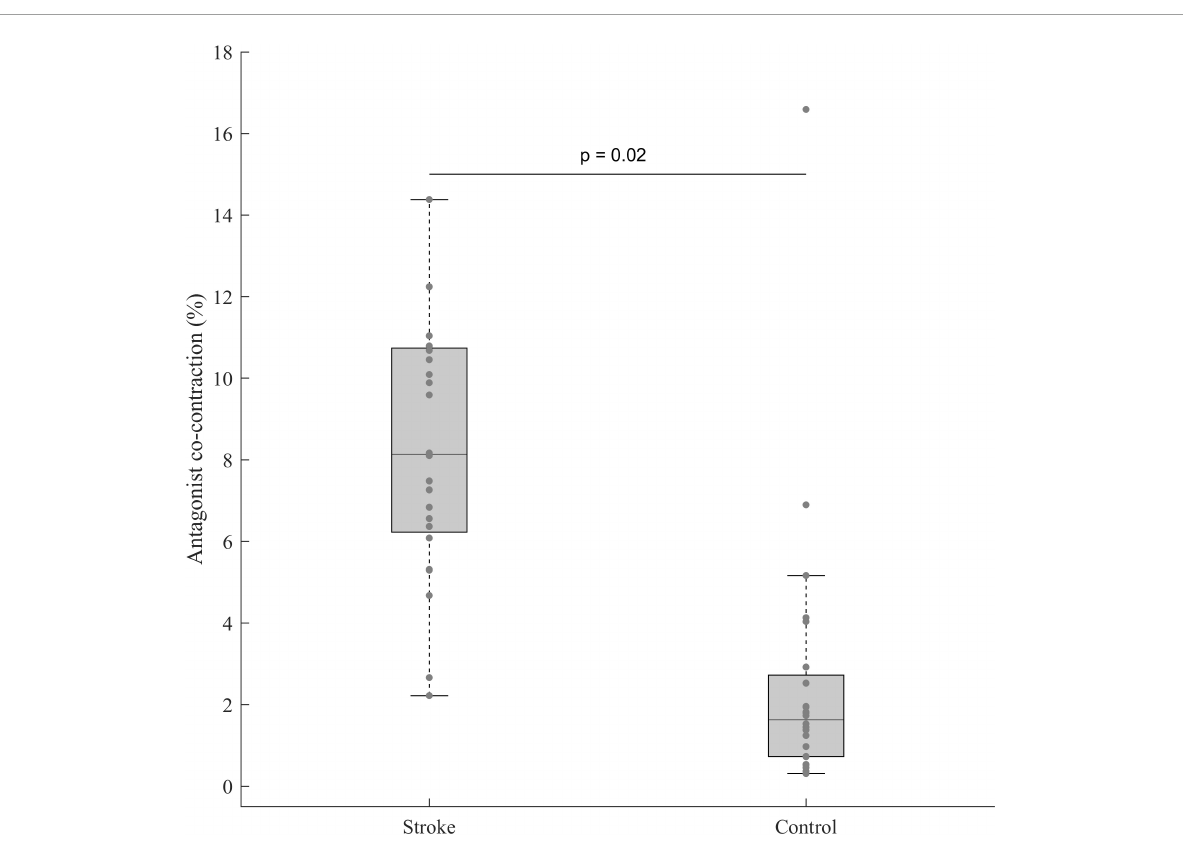
FIGURE4 Antagonist co-contraction in the paretic limb of stroke subjects (n = 24) and the dominant limb of control subjects ( n = 24). In each box, the center line represents the median, the top, and bottom of the box correspond to the 25th and 75th percentiles, and the whiskers represent the 10th and 90th